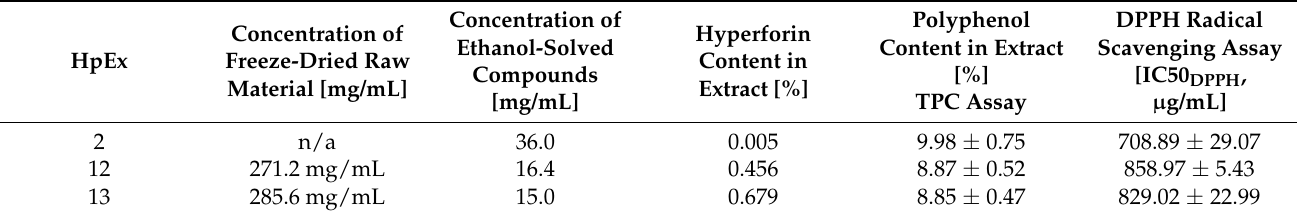
Table 1. The content of selected secondary metabolites and the radical scavenging activity of the ethanolic extracts of Hypericum perforatum . The values obtained for the extracts used in the DPPH assay were adjusted to a concentration of 3